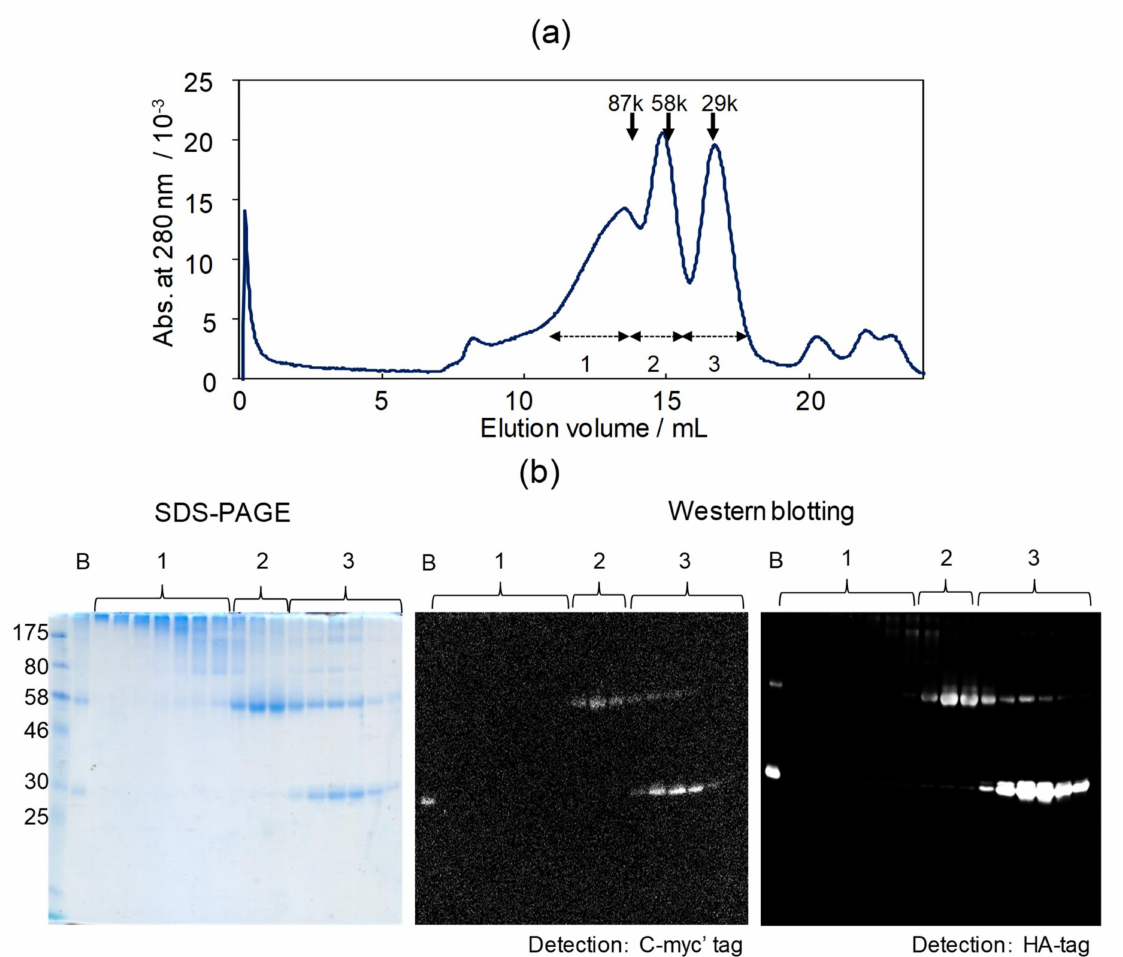
Figure 4. ( a ) Size-exclusion chromatography of reacted h528 HK19-0K scFvs, and ( b ) SDS-PAGE and western blotting for the reacted scFv (B) and the fractions in the chromatography (1~3). Western blotting used anti-c-myc (cid:48) antibodies conjugated with HRP (middle) and anti-HA antibodies with HRP